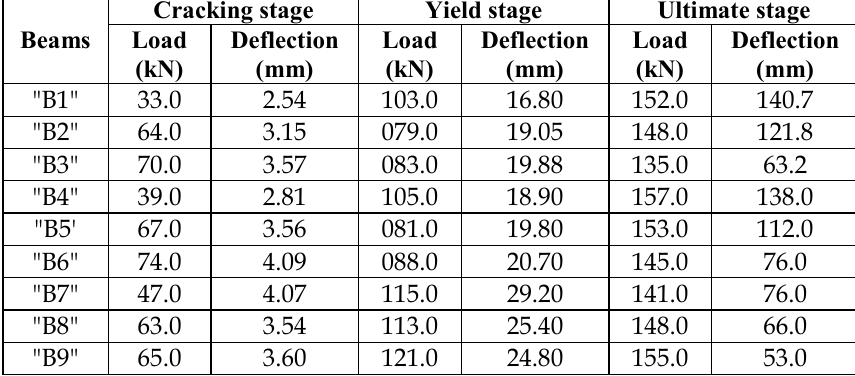
Experimental results for beams tested by Hussien et al. [6] . Cracking Beams